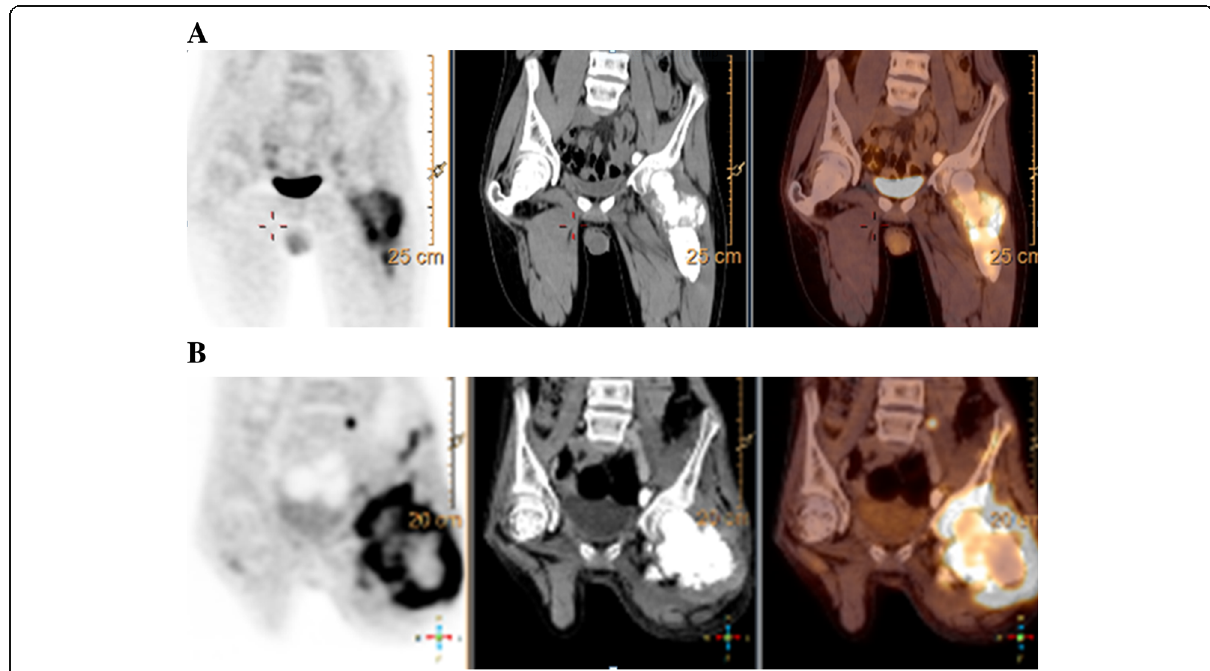
Fig. 5 A 18-year-old male with left femoral osteosarcoma. a Prechemotherapy coronal PET (left), coronal CT (middle), and coronal fused PET/CT (right) images revealed metabolically active FDG avid 1rt tumor (SUV 9). b Prechemotherapy coronal PET (left), coronal CT (middle), and coronal fused PET/CT (right) images revealed progression regarding size and FDG acidity (SUV = 19). Amputation was done and histopathology showed that there was 90% viable tumor (poor responder)